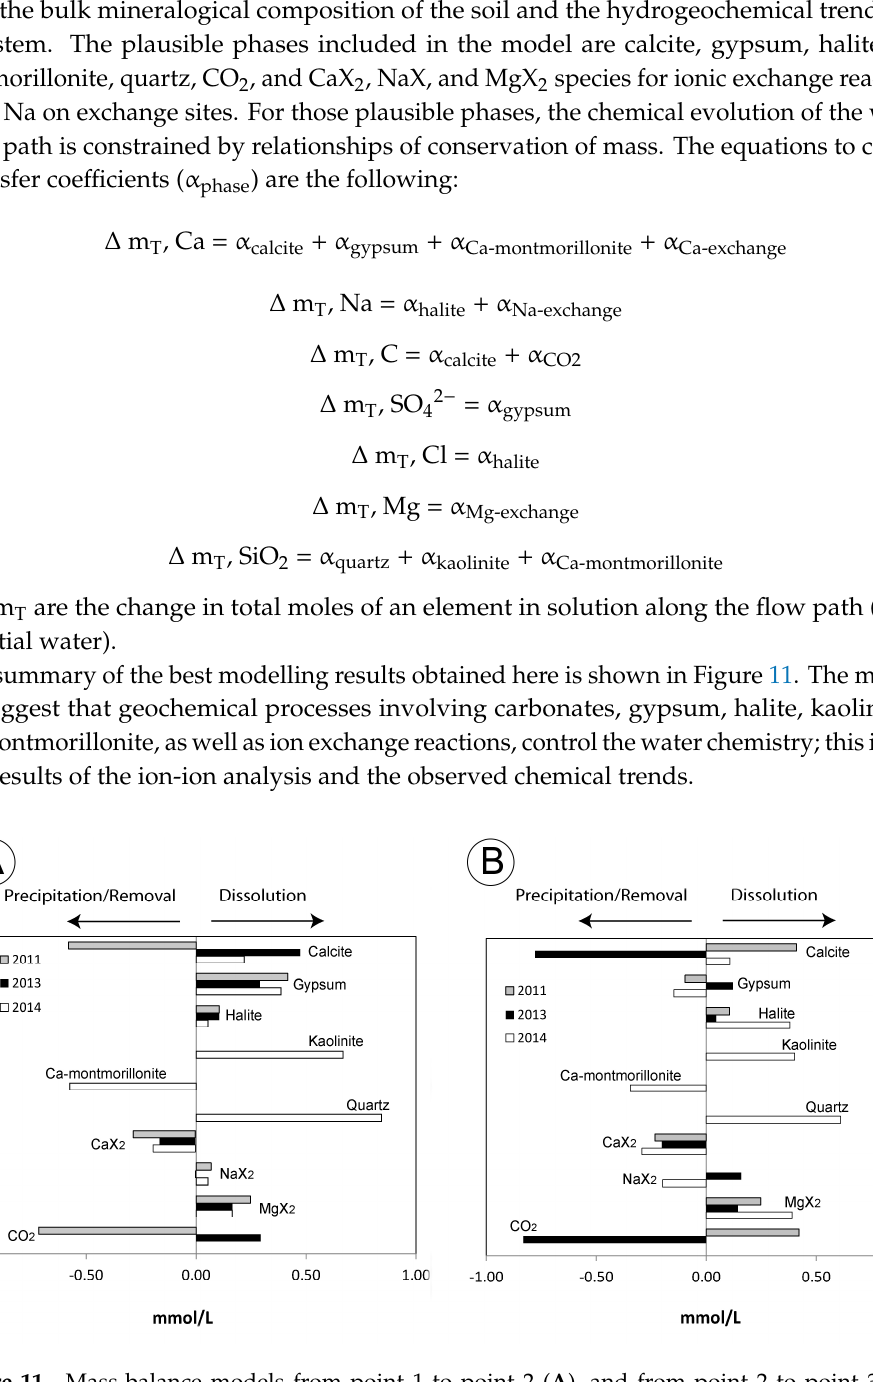
Figure 11. Mass-balance models from point 1 to point 2 ( A ), and from point 2 to point 3 ( B ) of the landslide.